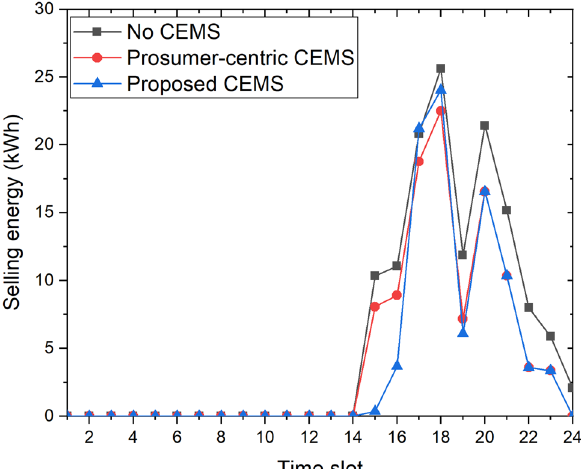
Figure 9. Selling energy of community with three CEMSs to EP.